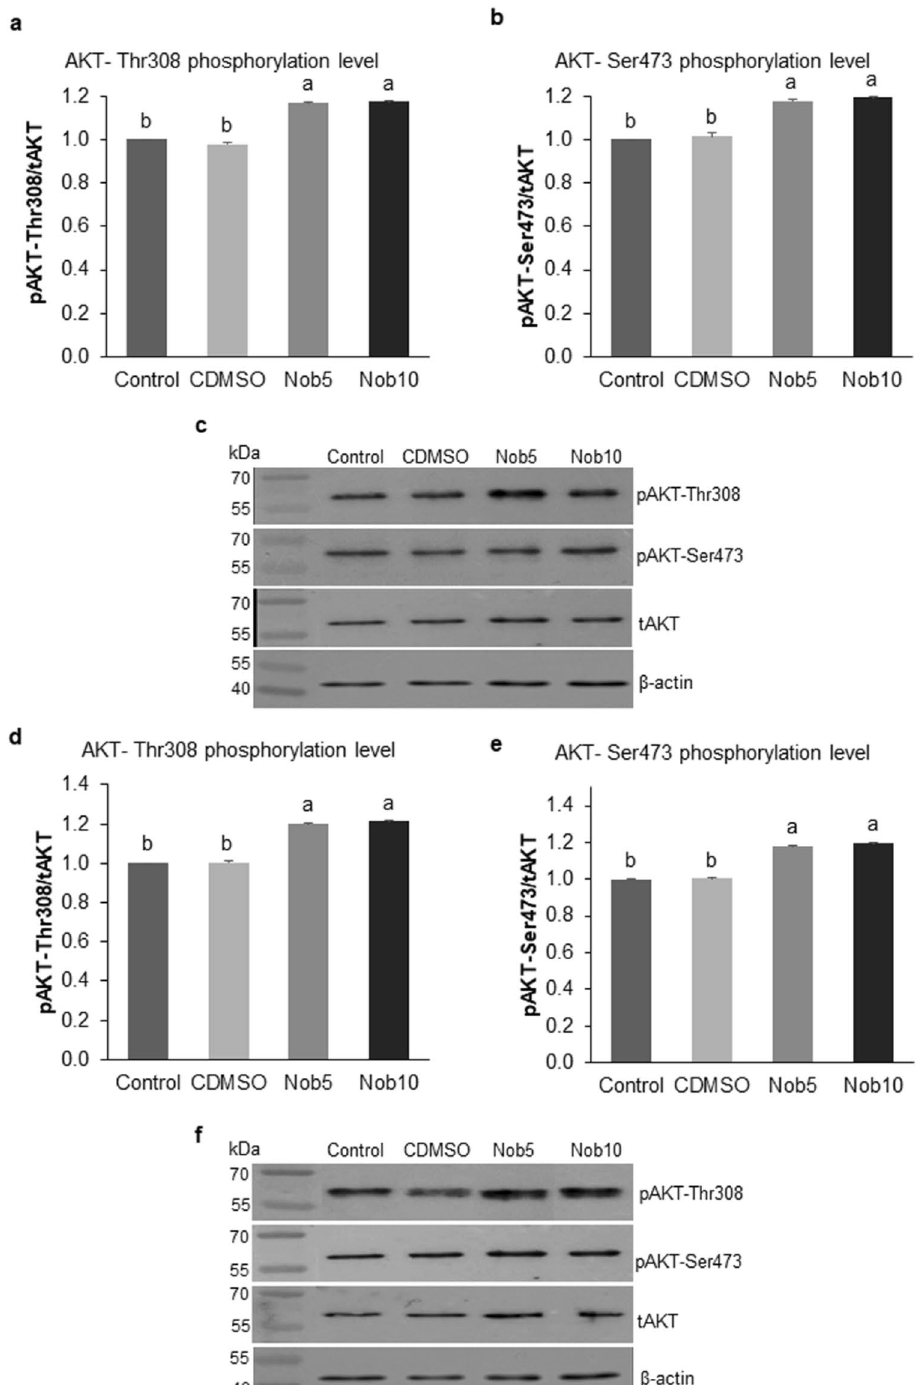
Figure 7. Nobiletin during MN EGA or MJ EGA increases AKT phosphorylation in blastocysts. ( a , b ) Quantification of phosphorylation levels of pAKT-Thr308/tAKT and pAKT-Ser473/tAKT in in vitro produced bovine Day 7 blastocysts cultured during 21–54 hpi (MN EGA : presumptive zygote to 8-cell stage) in SOF + 5% FCS (Control), supplemented or not with 5 µM (Nob5) or 10 µM (Nob10) nobiletin or with 0.03% dimethyl sulfoxide (C DMSO ). ( c ) Western blot images showing the expression of pAKT-Thr308, pAKT-Ser473, (t)AKT and β-actin in Day 7 blastocysts from MN EGA phase. ( d , e ) Quantification of phosphorylation levels of pAKT-Thr308/tAKT and pAKT-Ser473/tAKT in in vitro produced bovine Day 7 blastocysts cultured during 54–96 hpi (MJ EGA : 8- to 16-cell stage) in Control, Nob5, Nob10, and C DMSO . ( f ) Western blot images showing the expression of pAKT-Thr308, pAKT-Ser473, (t)AKT and β-actin in Day 7 blastocysts from MJ EGA phase. Data were normalized relative to the abundance of β-actin and p-AKT phosphorylation levels. Samples derive from the same experiment and gels were processed in parallel. Cropped western blot membrane images are shown here, while full-length blots are presented in Supplementary Figure S1. Data are the mean ± s.e.m. Different letters indicate significant difference ( P < 0.05) between